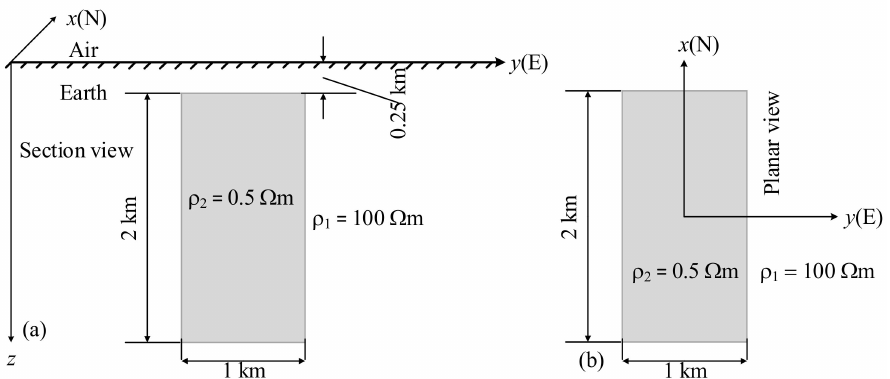
Figure 4. The COMMEMI 3D-1A model. ( a ) The section view, looking from negative to positive in